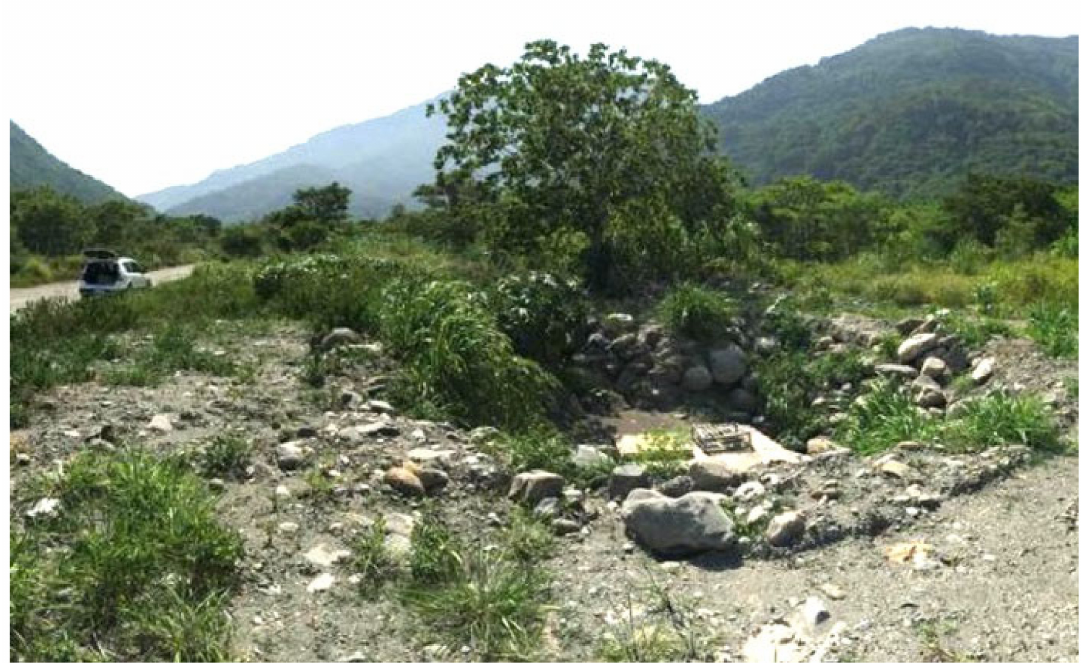
Figure 13. Recovered hot spring well which is located on the site shown in Figure